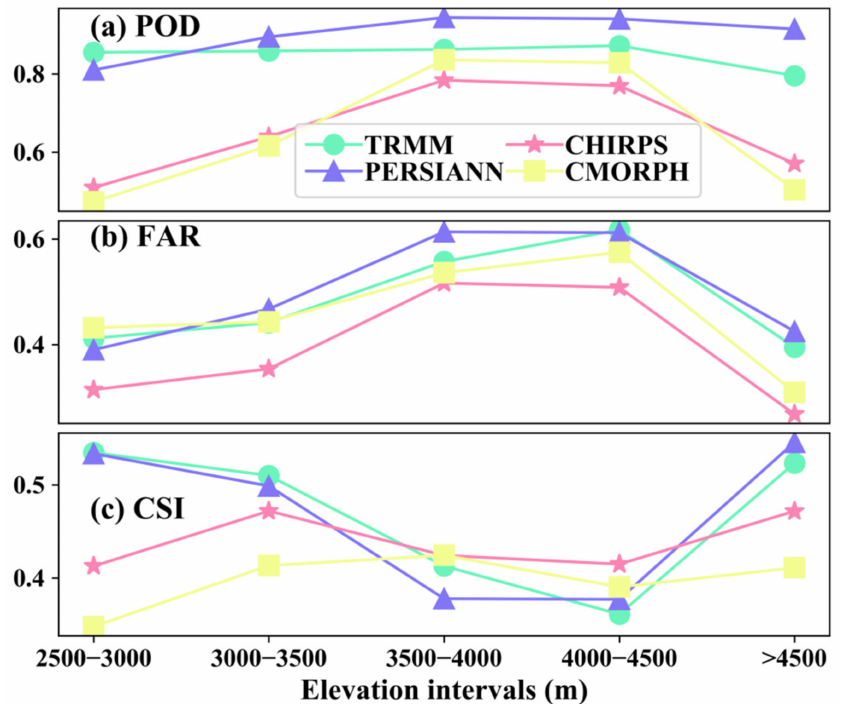
Figure 11. The line chart of the evaluation metrics calculated by daily precipitation for the four products at five altitude intervals: ( a ) POD, ( b ) FAR, ( c )